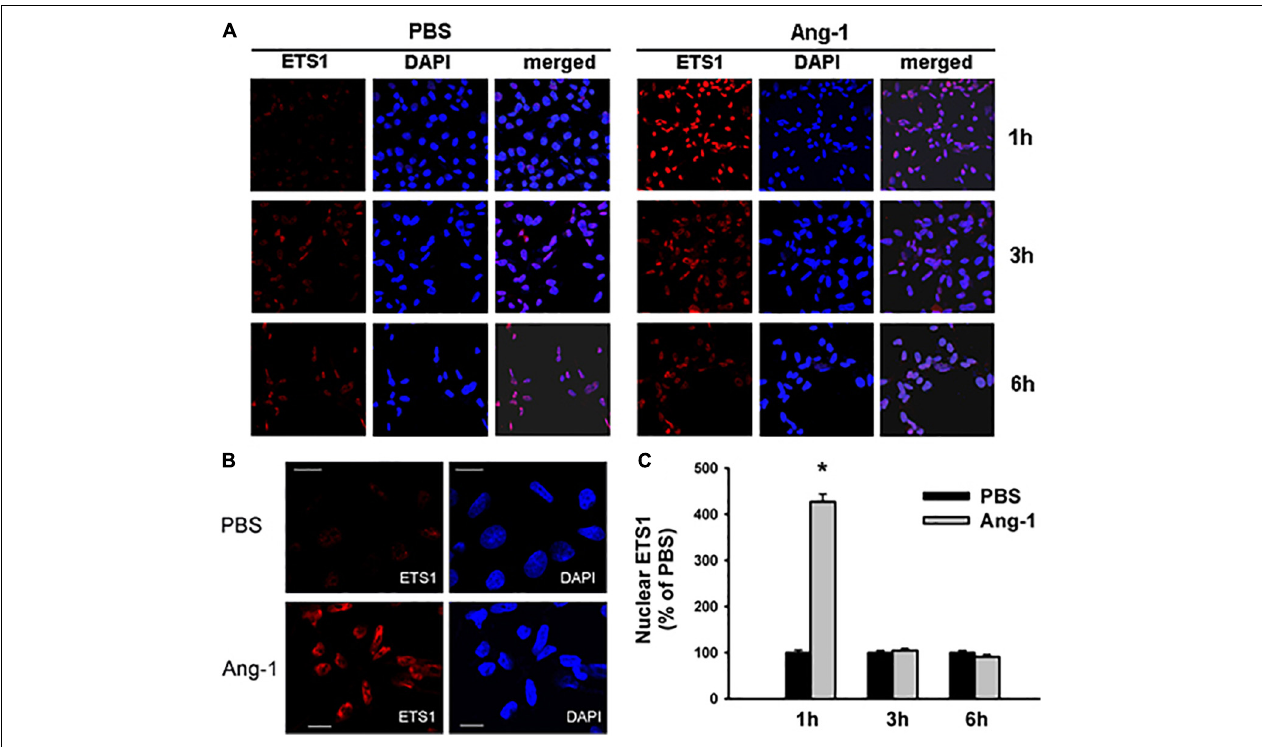
FIGURE 4 | Ang-1 increases nuclear localization of ETS1. (A) Representative immunofluorescence images of ETS1 protein (red color) and nuclear staining (DAPI, blue) in HUVECs exposed to PBS or Ang-1 for 1, 3, or 6 h. (B) ETS1 and DAPI staining in HUVECs exposed to PBS or Ang-1 for 1 h. (C) Fluorescence intensity of nuclear ETS1 in HUVECs exposed to PBS or Ang-1 for 1, 3, and 6 h. Values are means ± SEM, expressed as percent of PBS. * P < 0.05, compared to PBS. N > 130 cells per group. White bars in panel B indicate 20 µ